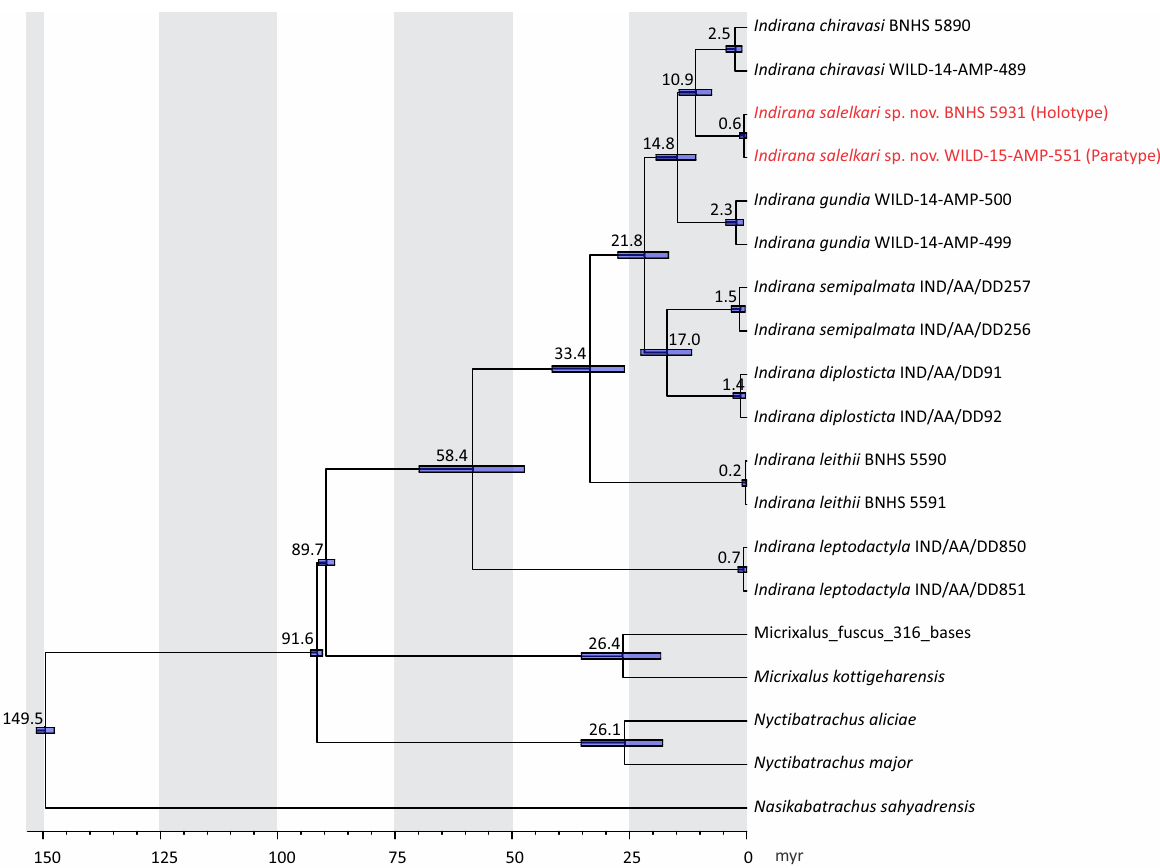
Figure 4. Molecular clock analysis based on concatenated sequences and separation of Nasikabatrachidae (149.5 mya), separation of Nyctibatrachidae (91.6 mya) and separation of Micrixalidae (89.7 mya) as calibration points. Blue bars are 95% HPD